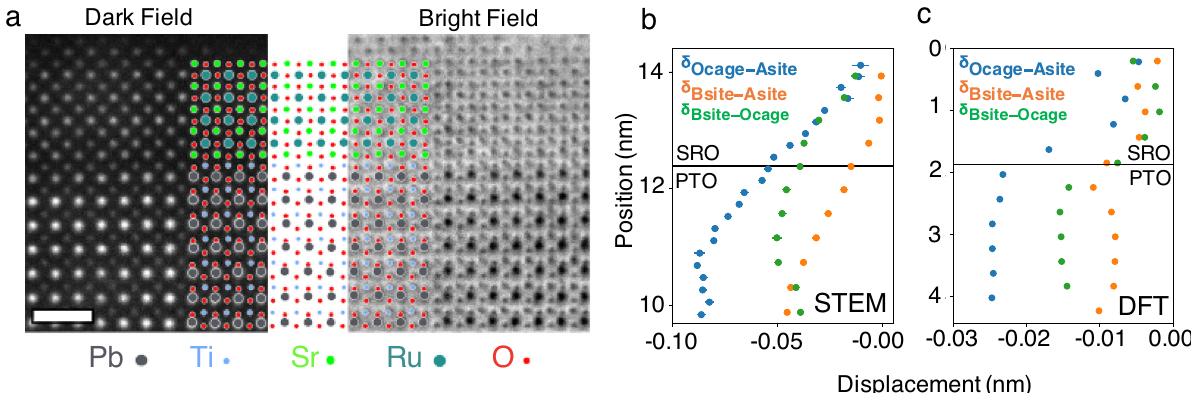
Fig. 4 TEM and DFT results of the interface. a Dark and bright fi eld TEM images of the SRO – PTO interface with fi tted atomic model overlayed. Scale bar is 1 nm. b Atomic displacements for the oxygen — A site shift (blue), the B site — A site shift (orange) and the B site to octahedral cage (green) acquired from the ABF images. c DFT simulated of the same atomic displacements around the SRO – PTO